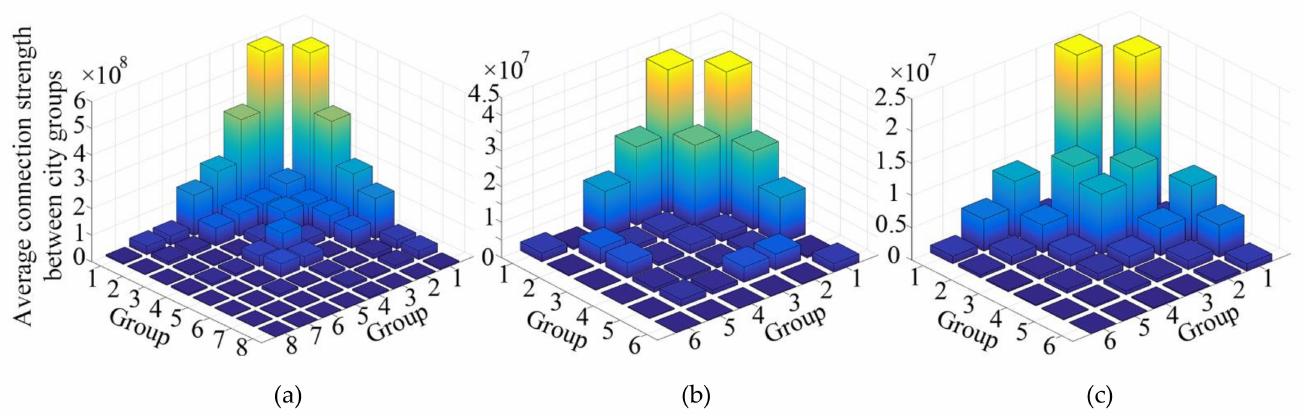
Figure 4. The block matrix of mesoscale structures: ( a ) English, ( b ) German, ( c ) French.